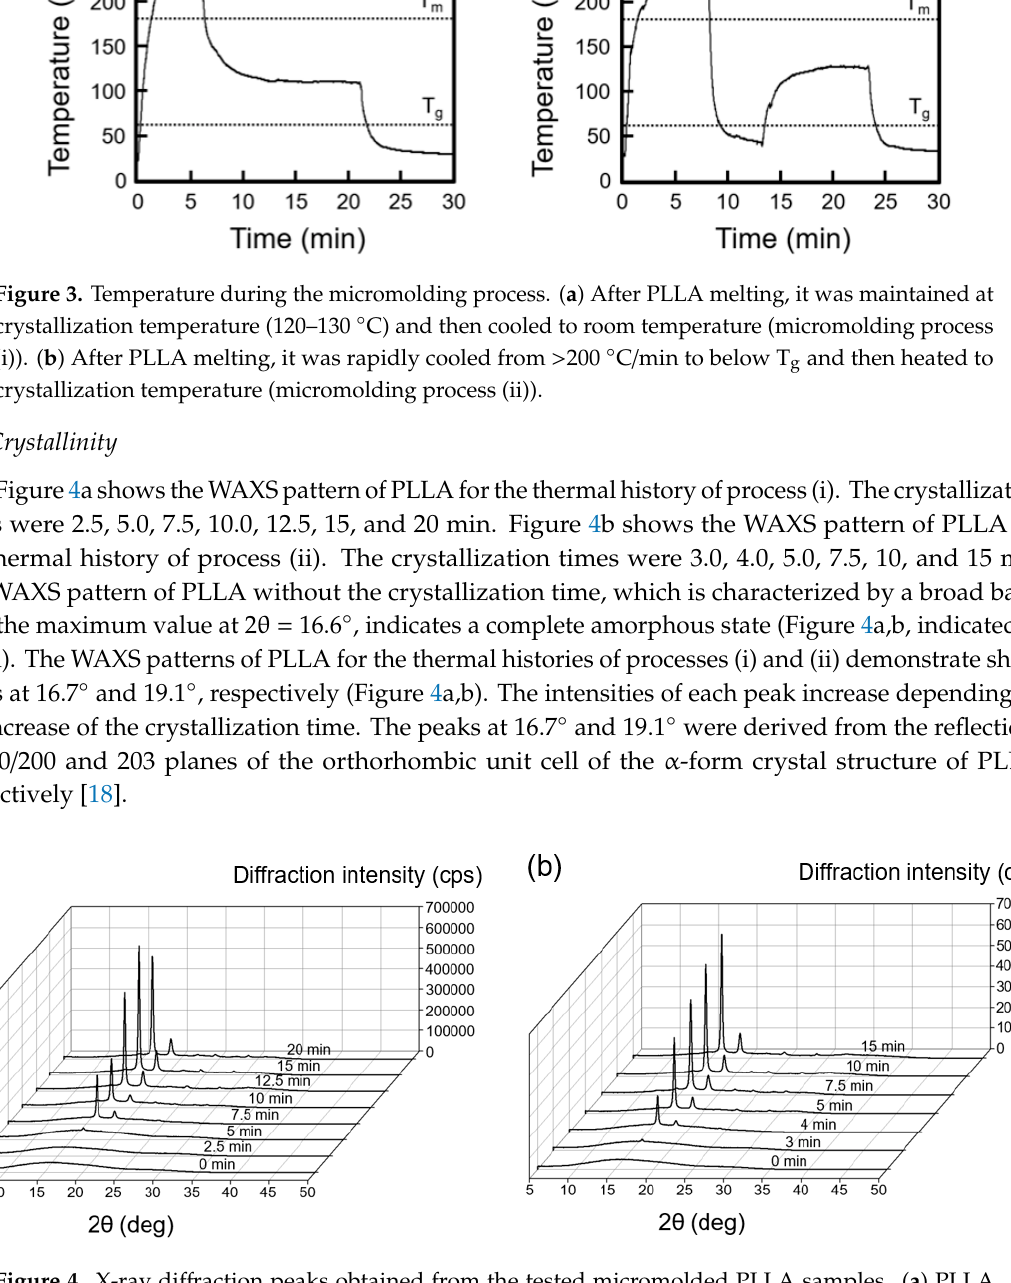
Figure 4. X-ray diffraction peaks obtained from the tested micromolded PLLA samples. ( a ) PLLA formed in micromolding process (i) with crystallization from the molten state. ( b ) PLLA formed in micromolding process (ii) with crystallization from the amorphous state.